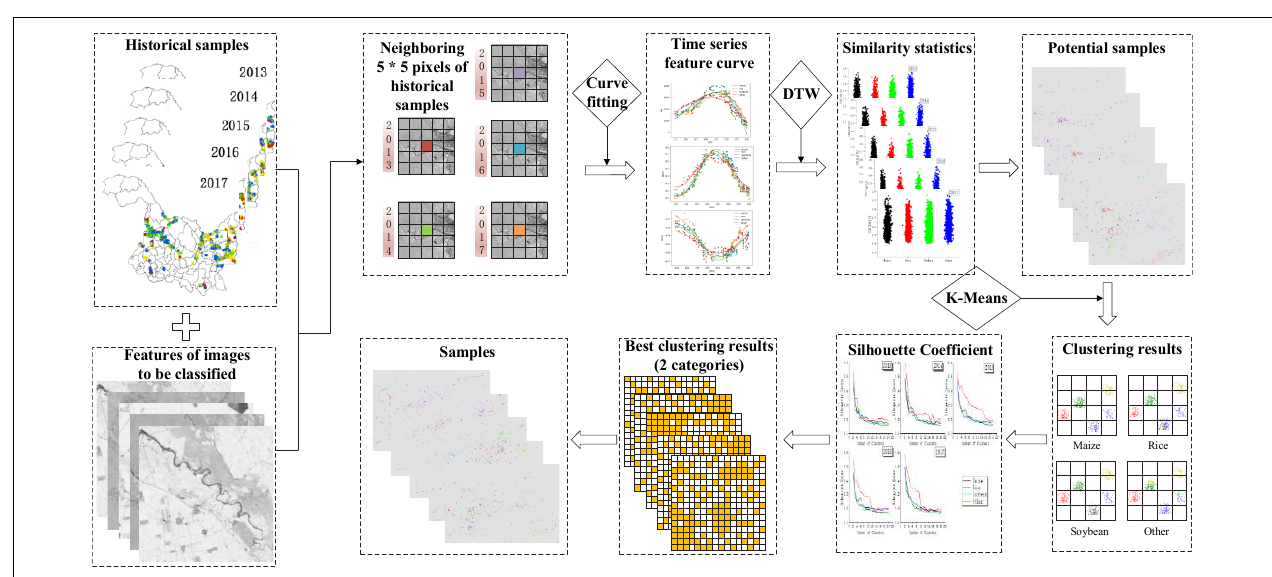
FIGURE 5 | Process of new sample